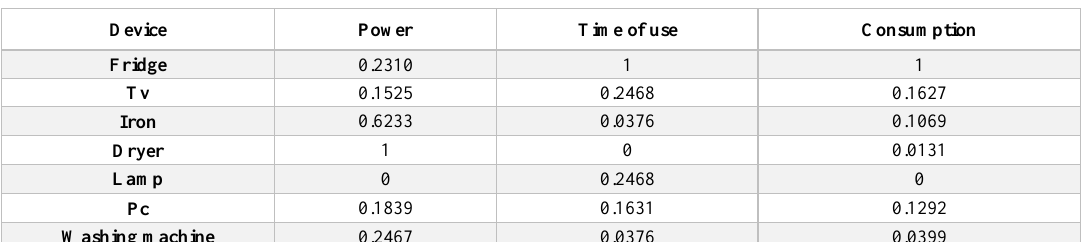
Table 3. Normalized